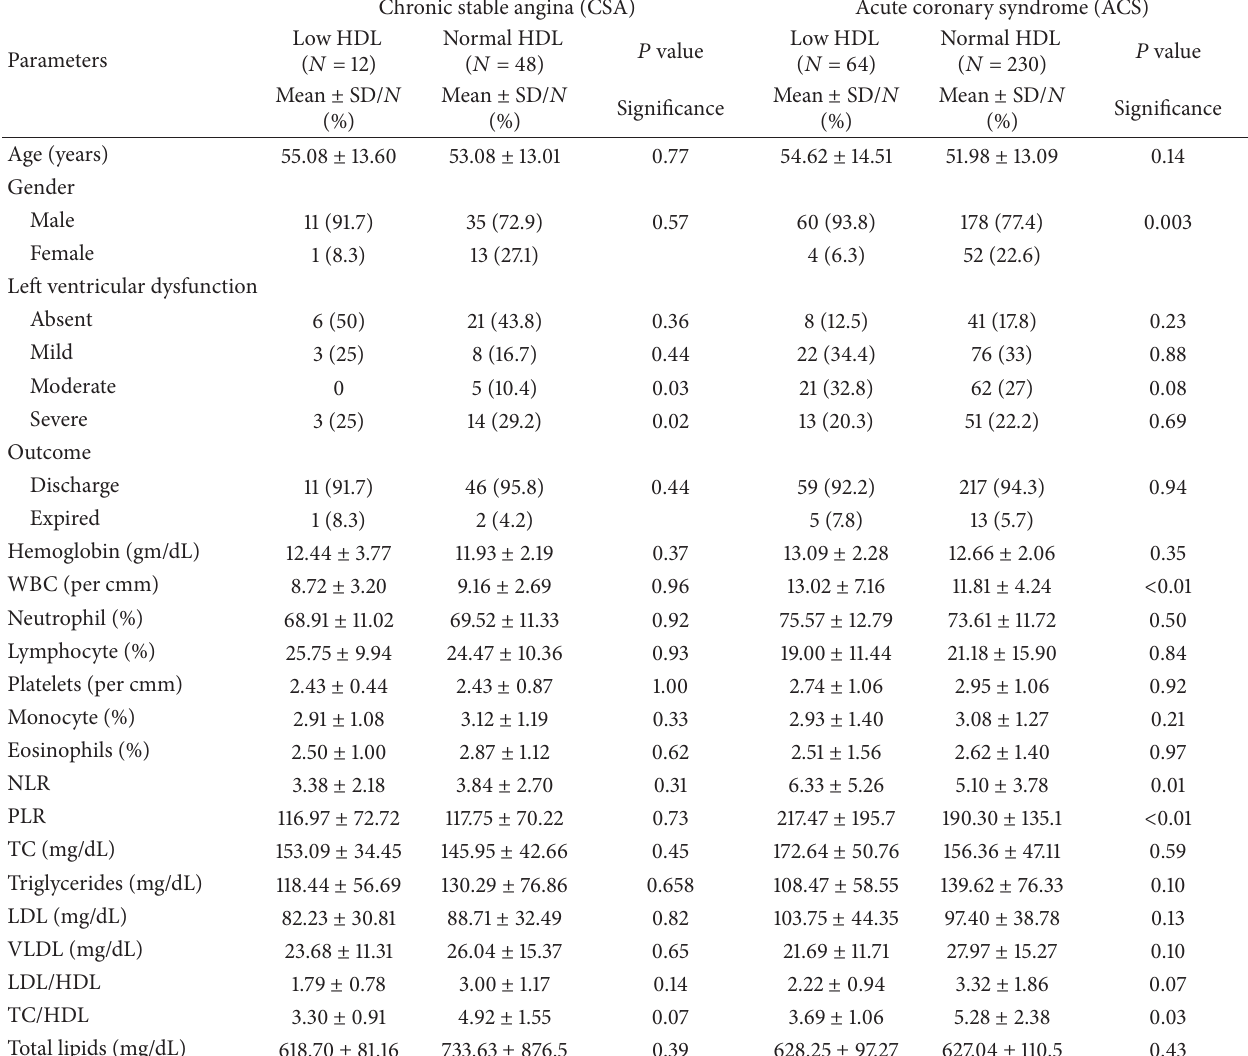
Table 3: Demographic, clinical, and laboratory characteristics according to HDL-C levels in CSA versus ACS population.